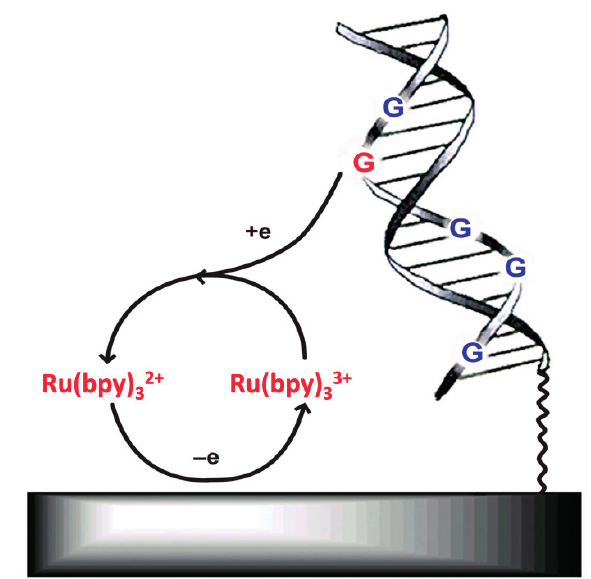
Figure 2. Using Ru(bpy) 32+ as a redox-active mediator to electrochemically detect DNA. Adapted with permission from ref. [34], copyright (2003) Nature Publishing Group.